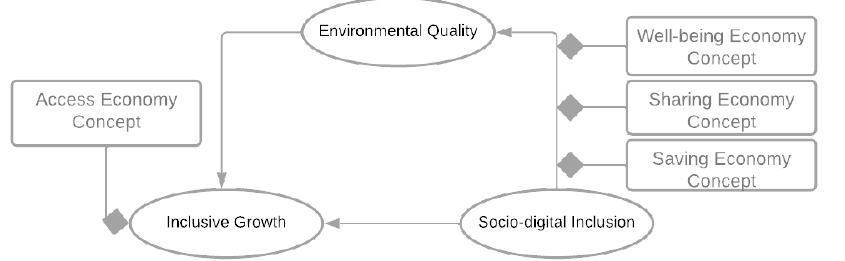
Figure 2. Conceptual framework of environment, inclusive growth and socio-digital inclusion. Source: developed by the authors.